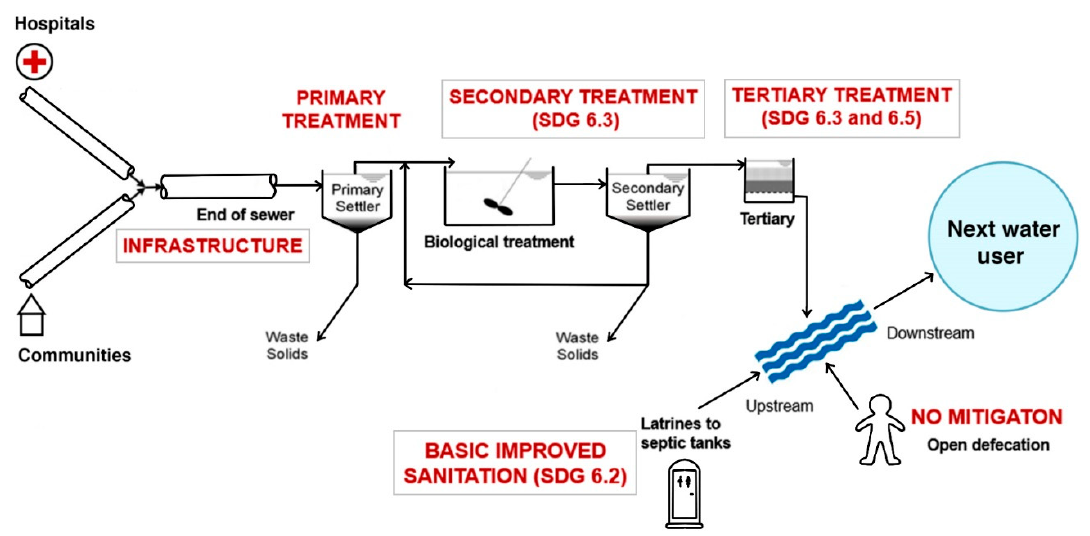
Figure 1. Locations in a waste management system where antibiotic resistance (AR) mitigation interventions might occur, aligned with Sustainable Development Goal 6.0. For the purpose of comparing options, the intervention steps are Basic Improved Sanitation, Primary Treatment, Secondary Treatment and Tertiary Treatment. However, it is assumed some level of infrastructural investment is needed to transition from basic interventions to secondary treatment.